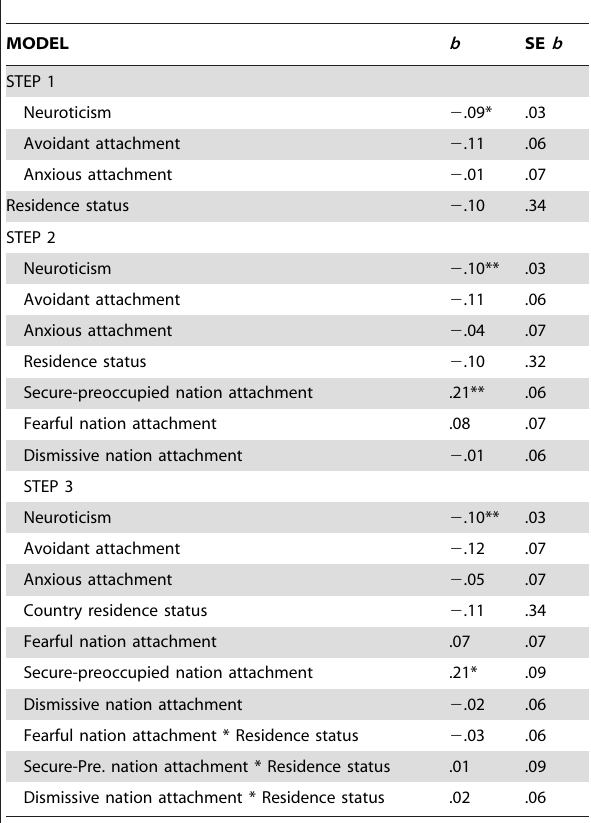
Table 4. Association of Nation Attachment with SWB.